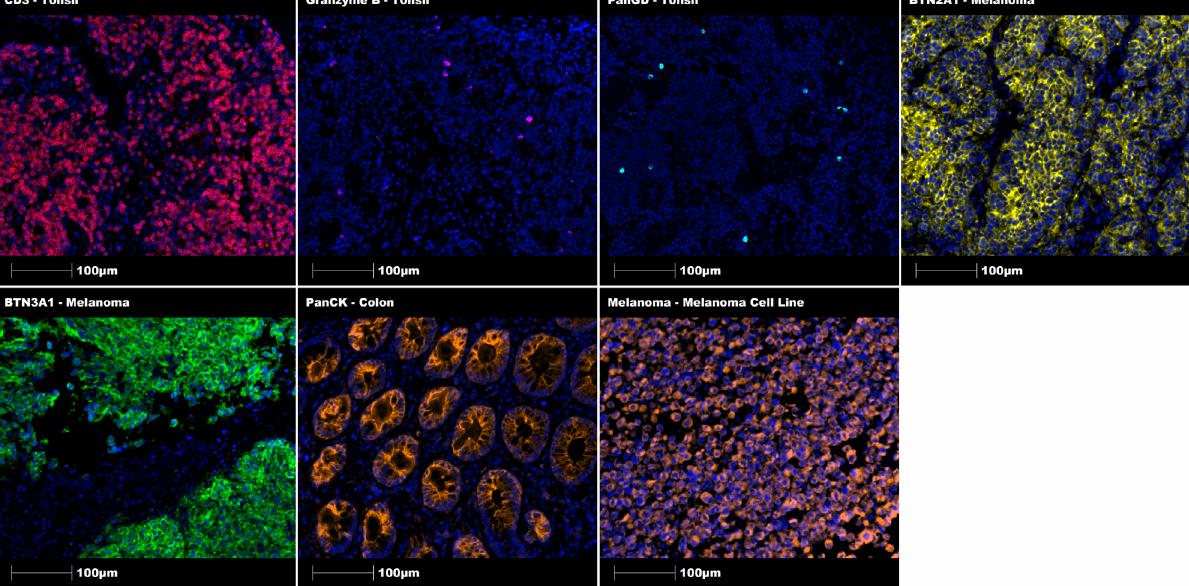
Two 7-marker mIHC panels were subsequently optimised for the detection of γδ T cells and BTN